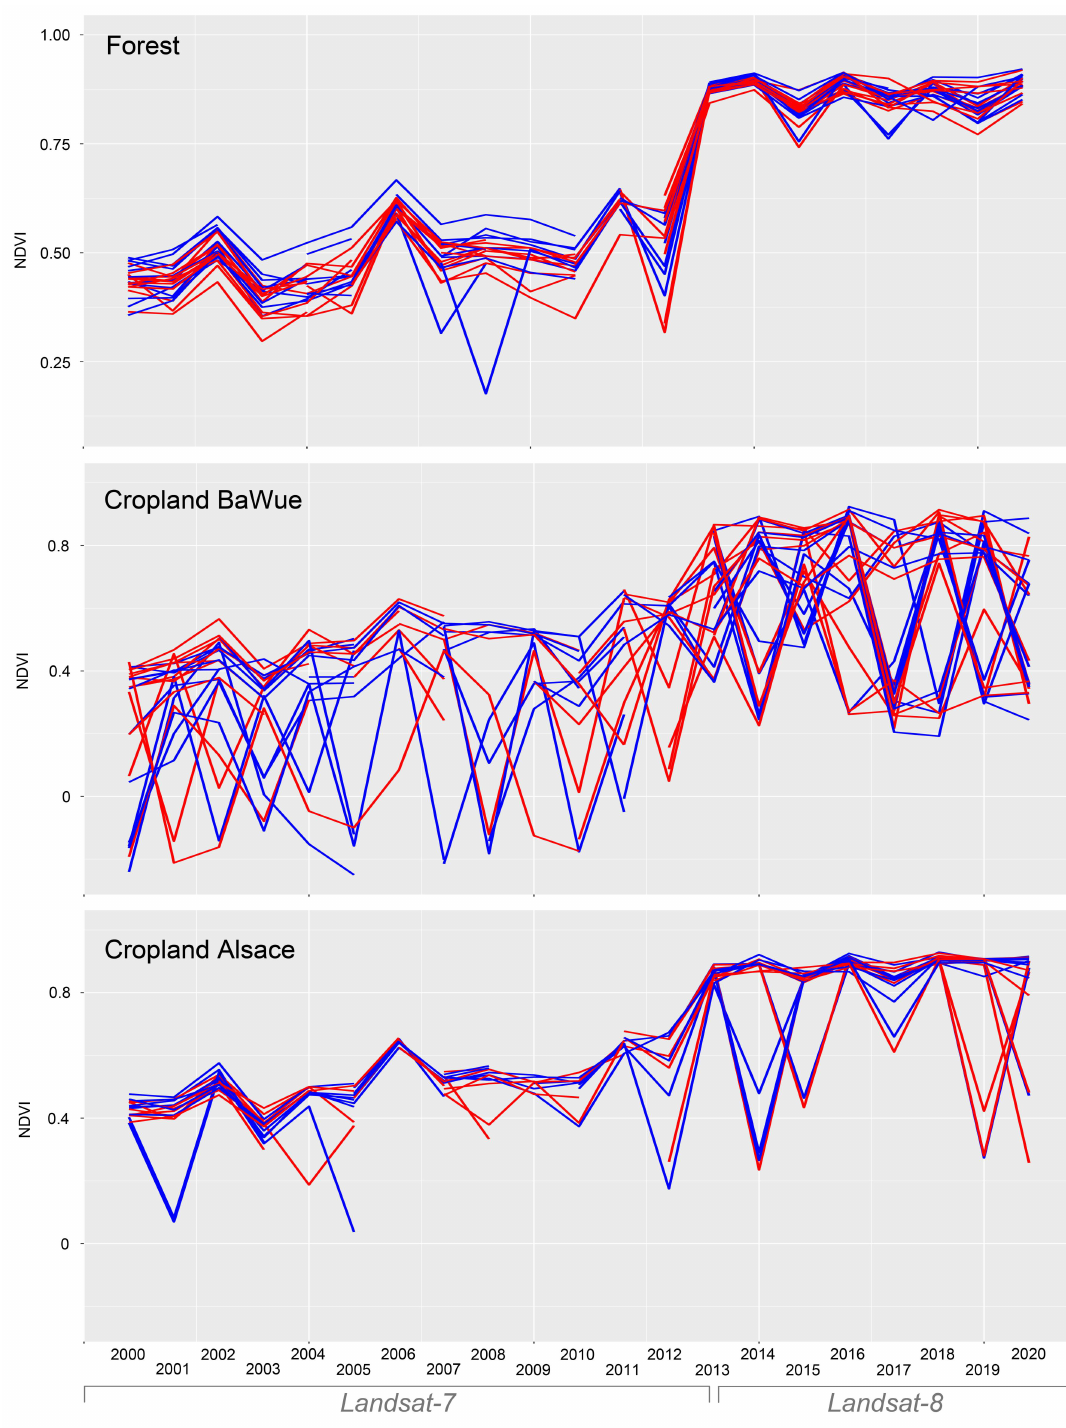
Figure 5. Comparison dataset for July and early August 2000–2020 based on Landsat-7 and Landsat-8 satellite imagery. Forest stands show rather homogeneous reflectance characteristics with increasing fuzziness during the period 2018–2020. BaWue cropland behaves significantly fuzzy compared to the Alsace, which highlights the continuous and static crop cultivation strategy in the French part of the Upper Rhine Area. Landsat-7 and Landsat-8 show a general difference in NDVI value characteristics.